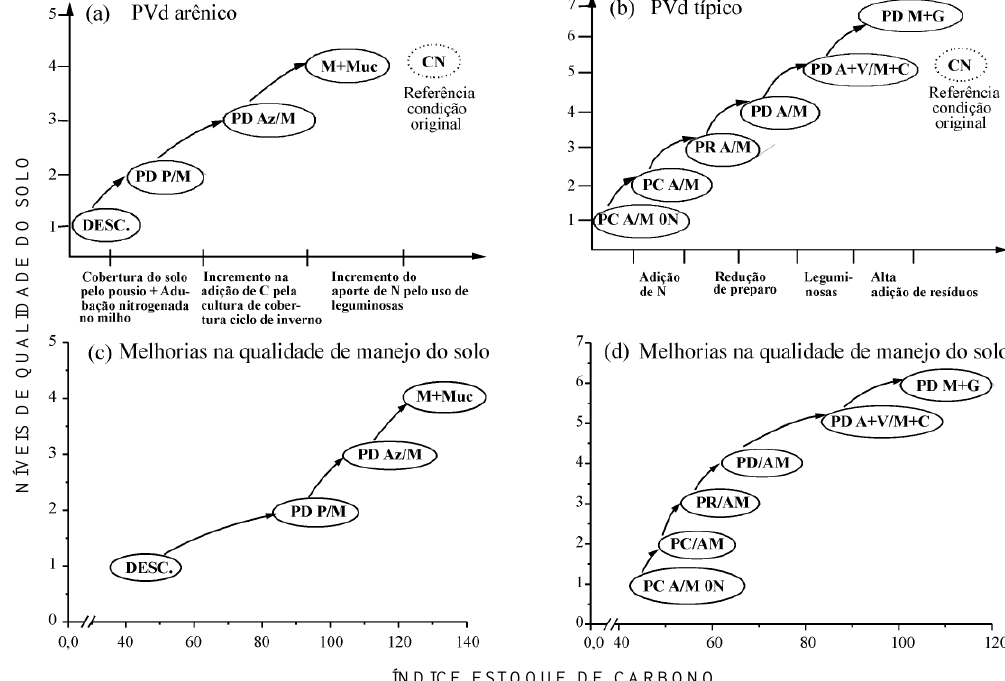
Figura 1. Sistema de organização teórico proposto para a ordenação da qualidade do solo segundo as melhorias de manejo (a, b) e a relação do índice estoque de carbono (IEC) com os mesmos níveis de qualidade do solo (c, d). DESC. = solo descoberto; CN = campo natural; PC = preparo convencional; PR = preparo reduzido; PD = plantio direto; Az = azevém; P = pousio; Muc = mucuna; A = aveia; M = milho; V = ervilhaca; C = caupi; G= guandu; e 0N = sem adubação nitrogenada. PVd arênico = Argissolo Vermelho distrófico arênico; PVd típico = Argissolo Vermelho distrófico